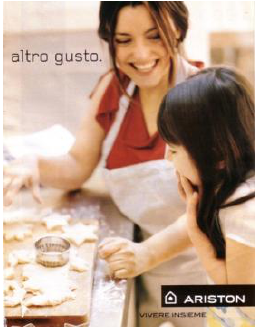
Figure A3. Own selected picture, woman and daughter.